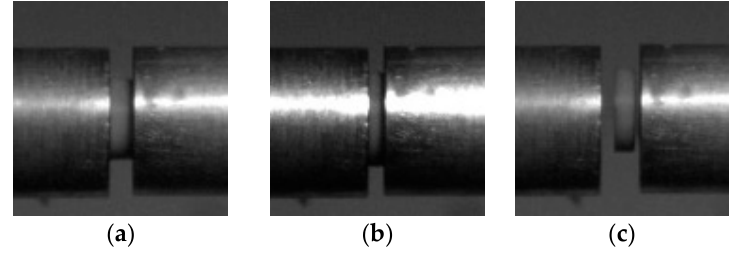
Figure 4. The high-speed photos of deformation of specimen: ( a ) before, ( b ) during, and ( c ) after.